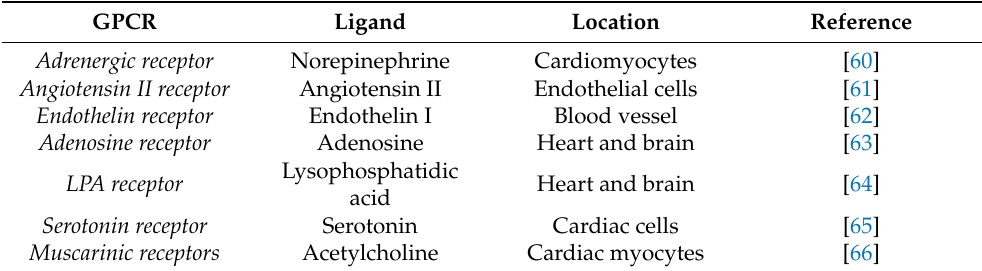
Table 1. Different GPCRs, ligands, and their locations in the body.